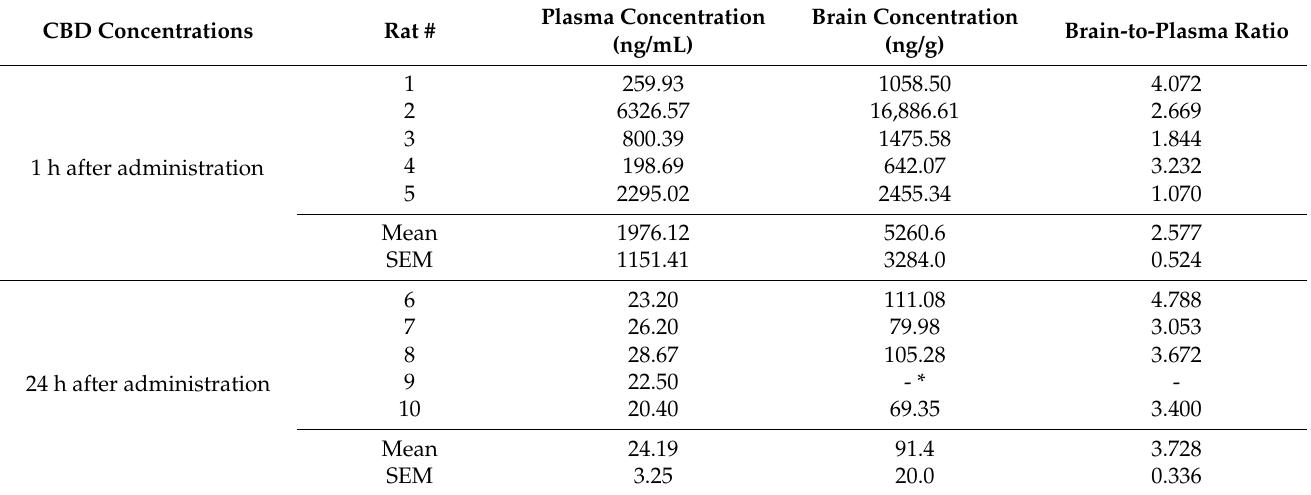
Table 1. Cannabidiol concentrations in plasma and brain at Cmax and Cmin after the oral admin ‐ istration of 60 mg/kg body weight.